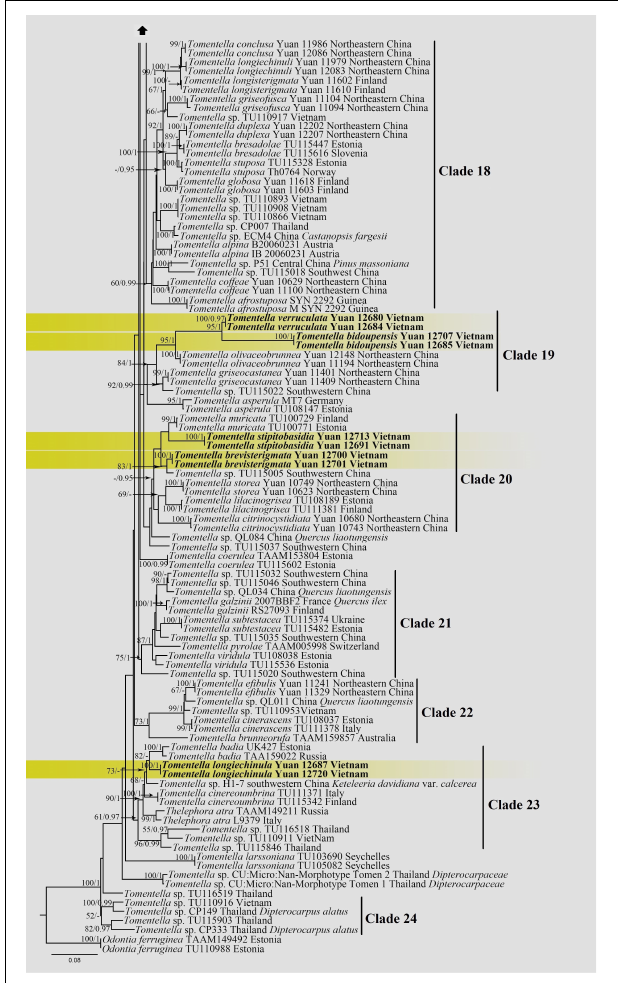
FIGURE 1 | Maximum likelihood tree illustrating the phylogeny of Tomentella bidoupensis , T. brevisterigmata , T. cinereobrunnea , T. longiechinula , T. stipitobasidia , T. verruculata , and related taxa, based on ITS + LSU nuclear rDNA sequences dataset. Branches are labeled with maximum likelihood bootstrap equal to or higher than 50% and Bayesian posterior probabilities equal to or higher than 0.95. The terminals indicate the regions where they were distributed or the hosts of the Tomentella species. New species in bold